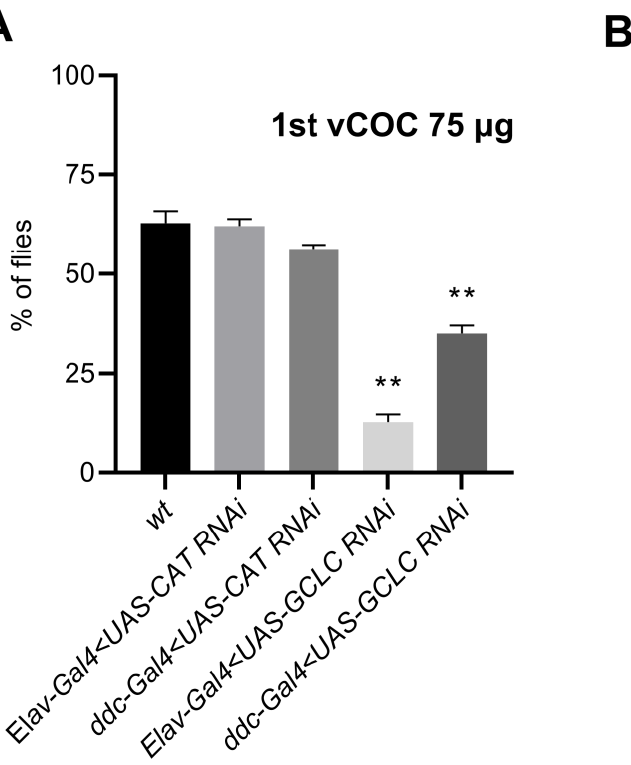
Figure 5. Oxygen and glutathione based redox modulation in dopaminergic and serotonergic ( ddc ) neurons influences the development of locomotor sensitization to vCOC. CAT and GCLC expression were prevented using RNAi (UAS-CAT RNAi or UAS-GCLC RNAi) constructs in all neurons or dopaminergic and serotoninergic neurons ( Elav -Gal4 or ddc -Gal4). ( A ) Percent of individual flies that increased locomotor activity relative to baseline activity after single exposure to 75 µ g vCOC at 09:00 (sensitivity). ( B ) Percent of individual flies that increased locomotor activity relative to baseline activity after single exposure at 09:00 and further increased activity after the second exposure at 15:00 to 75 µ g vCOC (locomotor sensitization). Data show five replicates ( n = 160) as average ± standard error mean (SEM). **: p < 0.01 One-way ANOVA with Tukey’s multiple comparison post-hoc test.